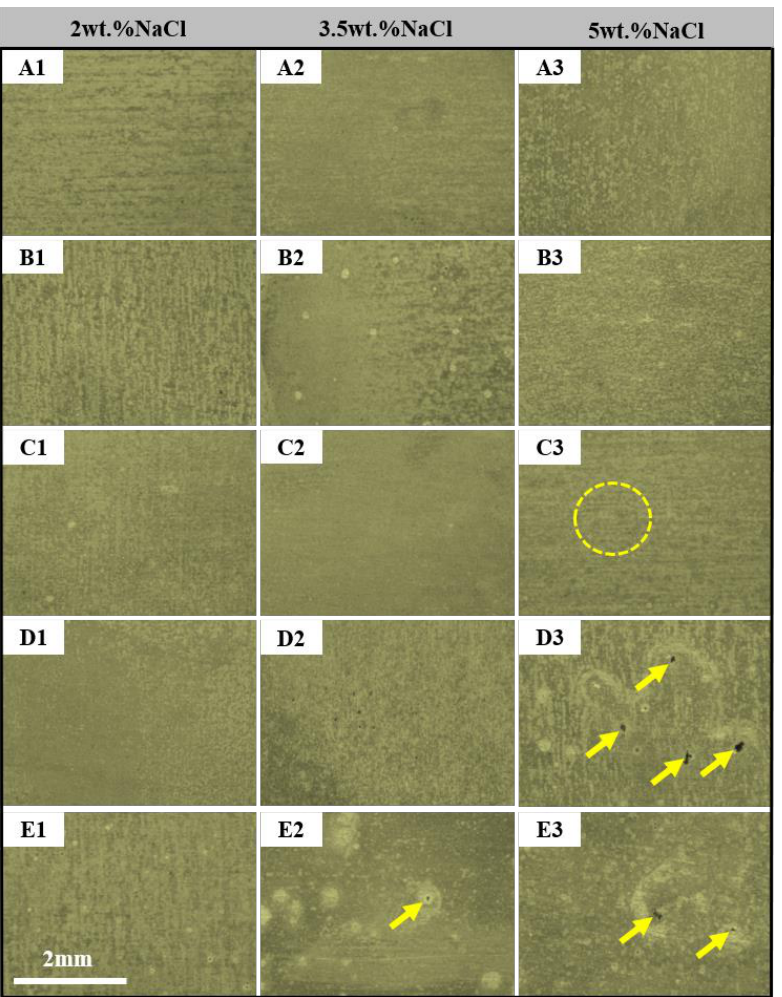
Figure 2. The macroscopic morphology of the alloys immersed in different concentrations of NaCl solution for 1 day ( A : 2A97-T3; B : 2A97-T6; C : 2024-T4; D : 2060-T8; E : 2099-T83).